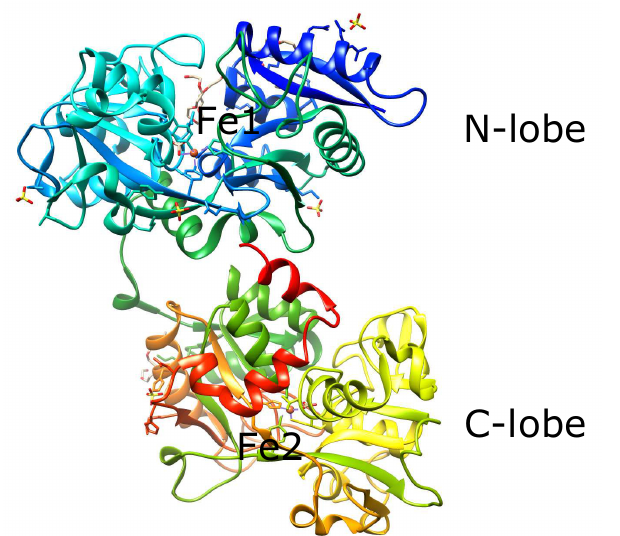
Figure 2. Human serum holotransferrin. The N-lobe is bluish and the C-lobe is lighter. Brown spheres in each lobe are iron ions. The protein structure was generated using UCSF Chimera [32]. PDB: